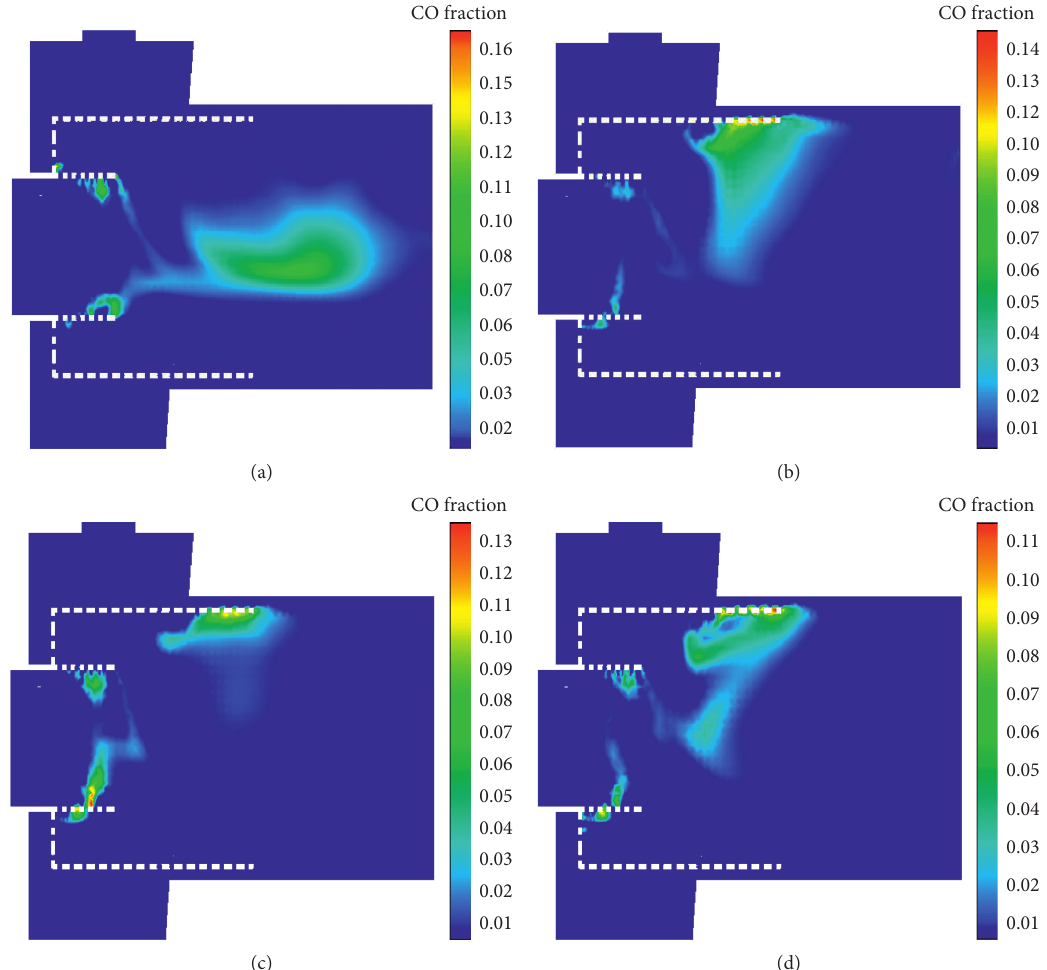
Figure 8: Longitudinal distribution of the CO concentration of the rotary burner under different excess air coefficients. (a) α � 1.0. (b) α � 1.4. (c) α � 1.8. (d) α � 2.2.